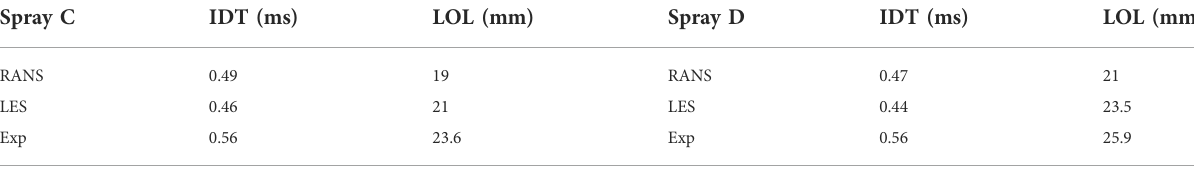
TABLE 4 Most important combustion parameters for Spray C (left) and Spray D (right) from simulations and experiments. Spray